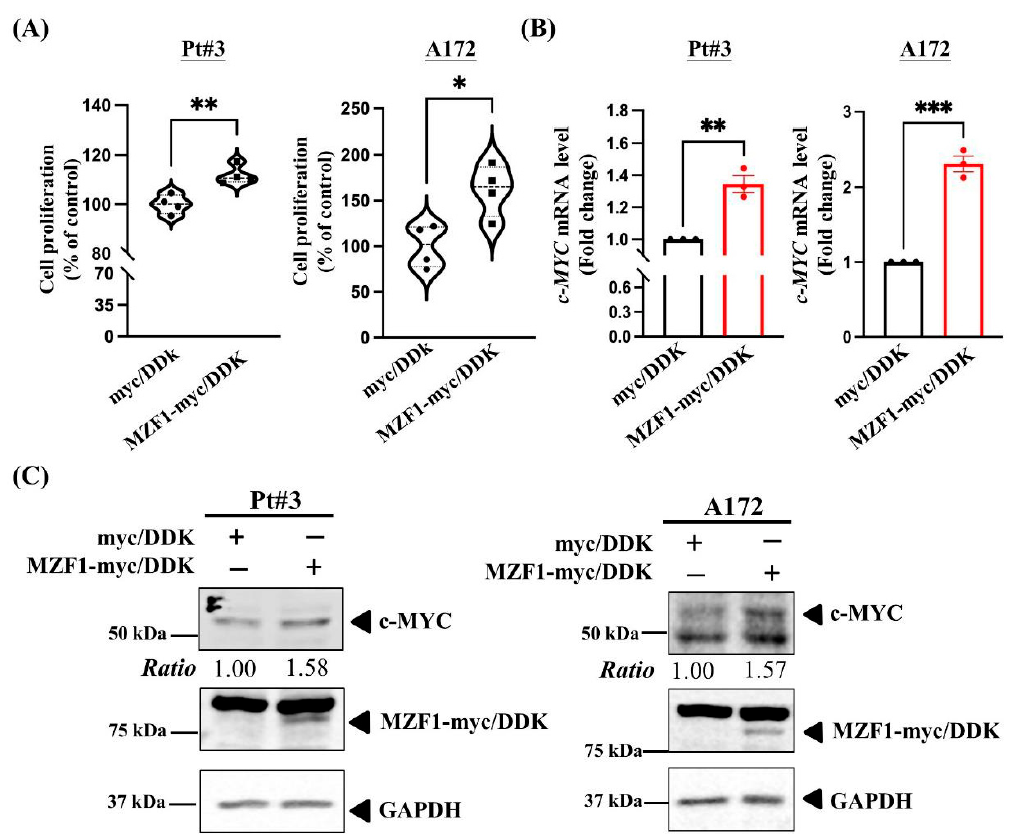
Figure 2. MZF1 overexpression promotes cell proliferation and increases c-MYC expression in PT#3 and A172 glioma cells. ( A ) A significant increase in cell proliferation was observed in MZF1-overexpressing PT#3 and A172 cells. Cell proliferation was assessed using the CCK8 assay, following the instructions provided with the kit. Data are collected from four independent experiments and presented as mean ± SEM; two-tailed unpaired Student’s t -test, p = 0.0048 (PT#3 cells); p = 0.0153 (A172 cells), * p < 0.05; ** p < 0.01. ( B ) The expression of c-MYC mRNA was increased in MZF1-overexpressing glioma cells. Real-time PCR analysis was conducted with c-MYC primers using cDNA harvested from MZF1-overexpressing PT#3 and A172 cells. Data are collected from three independent experiments and presented as mean ± SEM; two-tailed unpaired Student’s t -test, p = 0.0027 (Pt#3 cells) and p = 0.0002 (A172 cells), ** p < 0.01 and *** p < 0.001. ( C ) Western blot analysis demonstrated an increase in the c-MYC protein level in MZF1-overexpressing glioma cells. Cells transfected with empty vector were used as a control (myc-DDK).